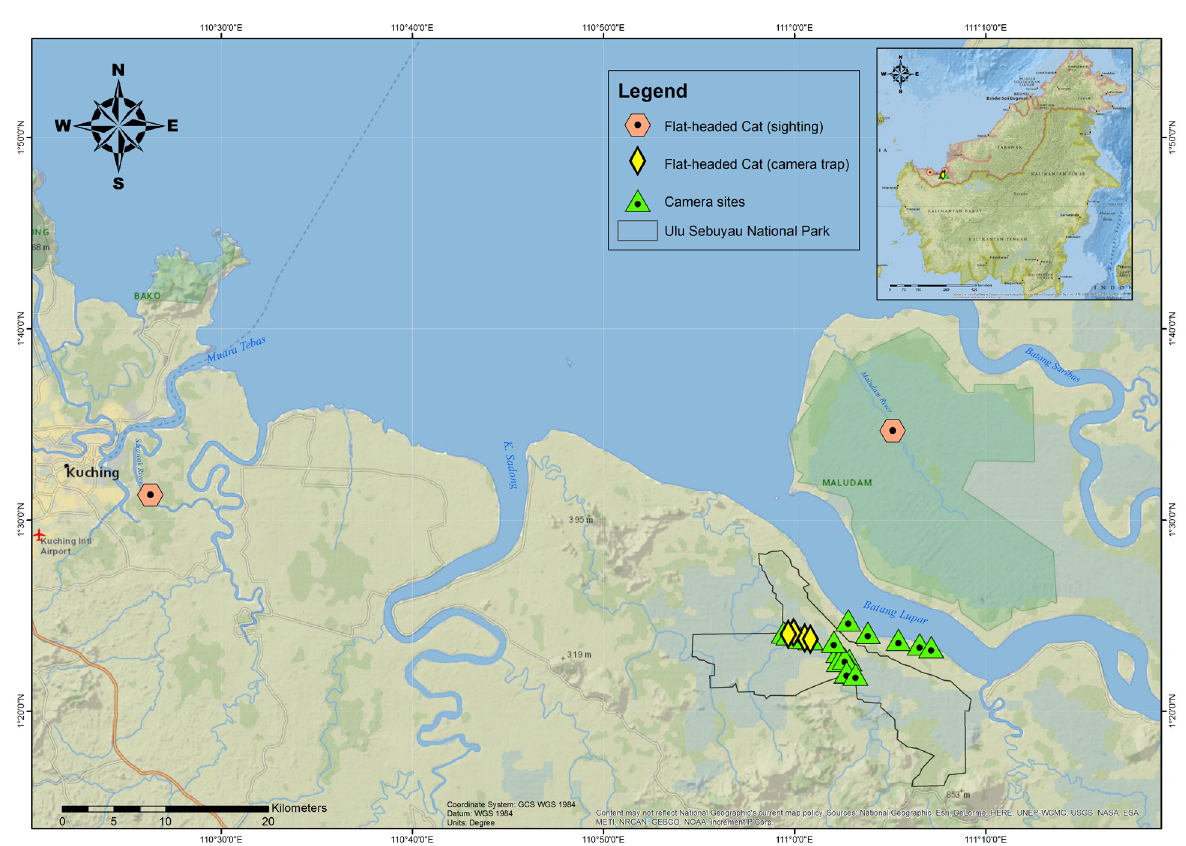
Figure 1. Camera trapping sites in Ulu Sebuyau National Park with locations where Flat-headed Cats were